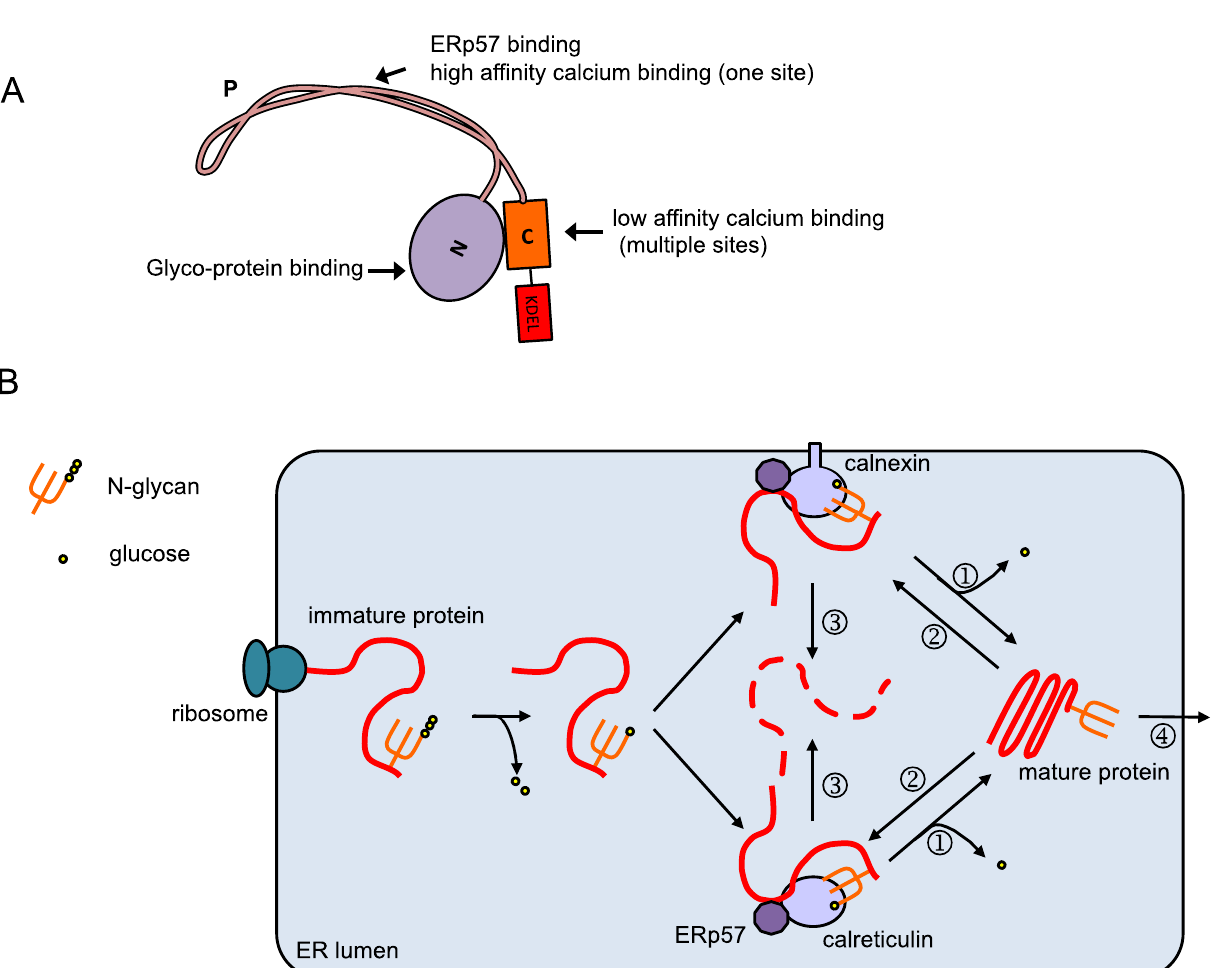
Figure 1. Overview of the calreticulin protein and its function. ( A ) Domain organization of calreticulin. The calreticulin protein contains the N-terminal signal peptide, N-domain, P-domain, C-domain and the ER-retention signal KDEL. The N- and P- domain are responsible for the chaperone function, while the C-domain is mainly responsible for calcium binding; ( B ) Calreticulin/calnexin cycle. Native protein peptides being synthesized on the rough ER translocate into the ER lumen and are glycosylated. The glycosylated protein is then modified by glucosidases I and II, and binds to calreticulin and/or calnexin. The oxidoreductase ERp57 associates with calreticulin and calnexin, and catalyzes the formation and breakage of protein disulfide bonds to assist folding. When folding is completed, glucosidases II further trims the glycan ( ① ) and the glycoprotein is released from calreticulin/calnexin and transported out of the ER ( ④ ). Incompletely-folded proteins are re-glucosylated by UGGT (UDP-glucose:glycoprotein transferase, ② ), and remain bound to calreticulin/calnexin to continue folding. Prolonged interaction with calreticulin/calnexin targets the proteins to ERAD (ER-associated degradation, ③